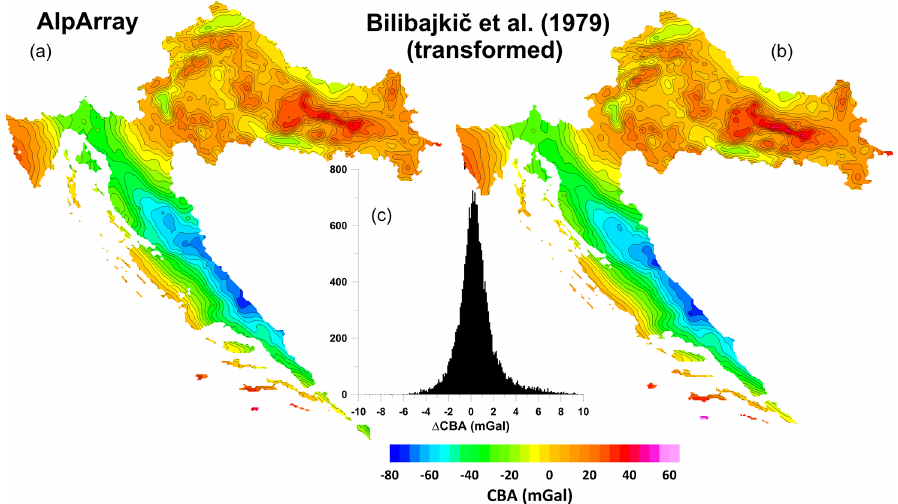
Figure 8. Comparison of CBA maps (density 2670kgm − 3 ) for the area of Croatia. The map on the left (a) is constructed from available data within the AlpArray project. The map on the right (b) was obtained by transforming the digitized map of the former SFR Yugoslavia (Bilibajkiˇc et al., 1979). The histogram in the middle (c) shows the differences between the maps.